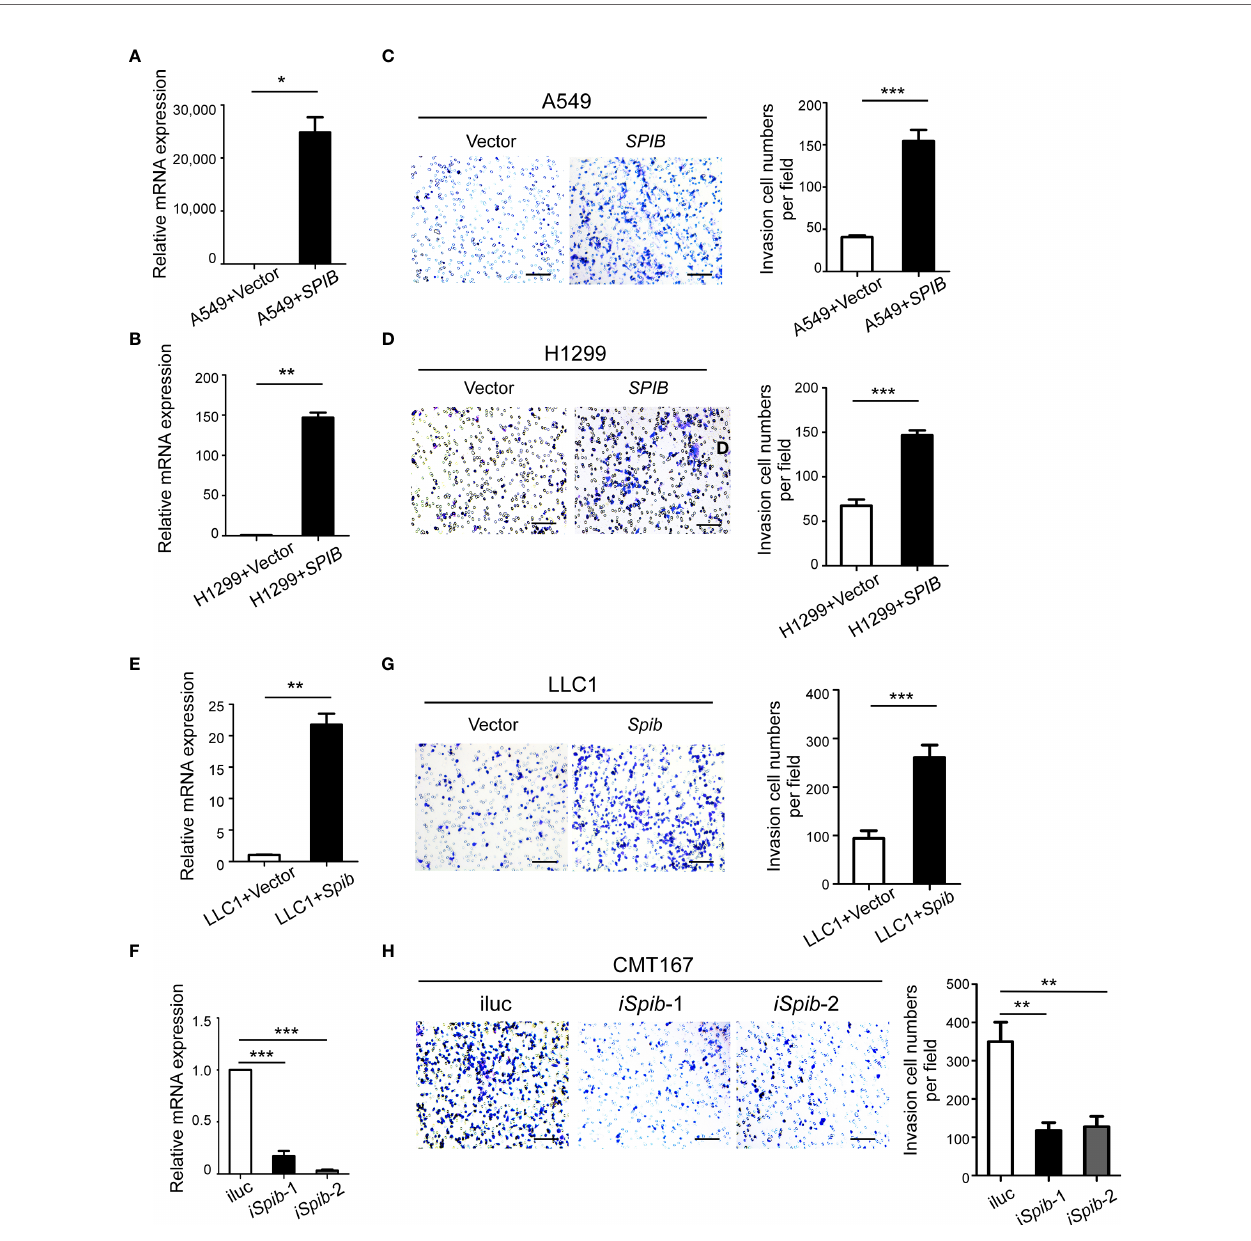
FIGURE 4 | SPIB promotes macrophage recruitment. (A, B, E, F) Human SPIB overexpression ef fi ciency in A549 (A) and H1299 (B) cells veri fi ed by qRT-PCR. Murine Spib overexpression ef fi ciency in LLC1 cells (E) and Spib silencing ef fi ciency in CMT167 cells (F) veri fi ed by qRT-PCR. *P < 0.05. **P < 0.01. ***P < 0.001. (C, D, G, H) Recruitment assay. Left, representative transwell images of recruited macrophages. Right, relative fold changes of recruited macrophages in each image fi eld observed by phase-contrast microscopy (200×). Columns, mean (n = 3). Bars, SD. **P < 0.01. ***P < 0.001. Scale bars, 100